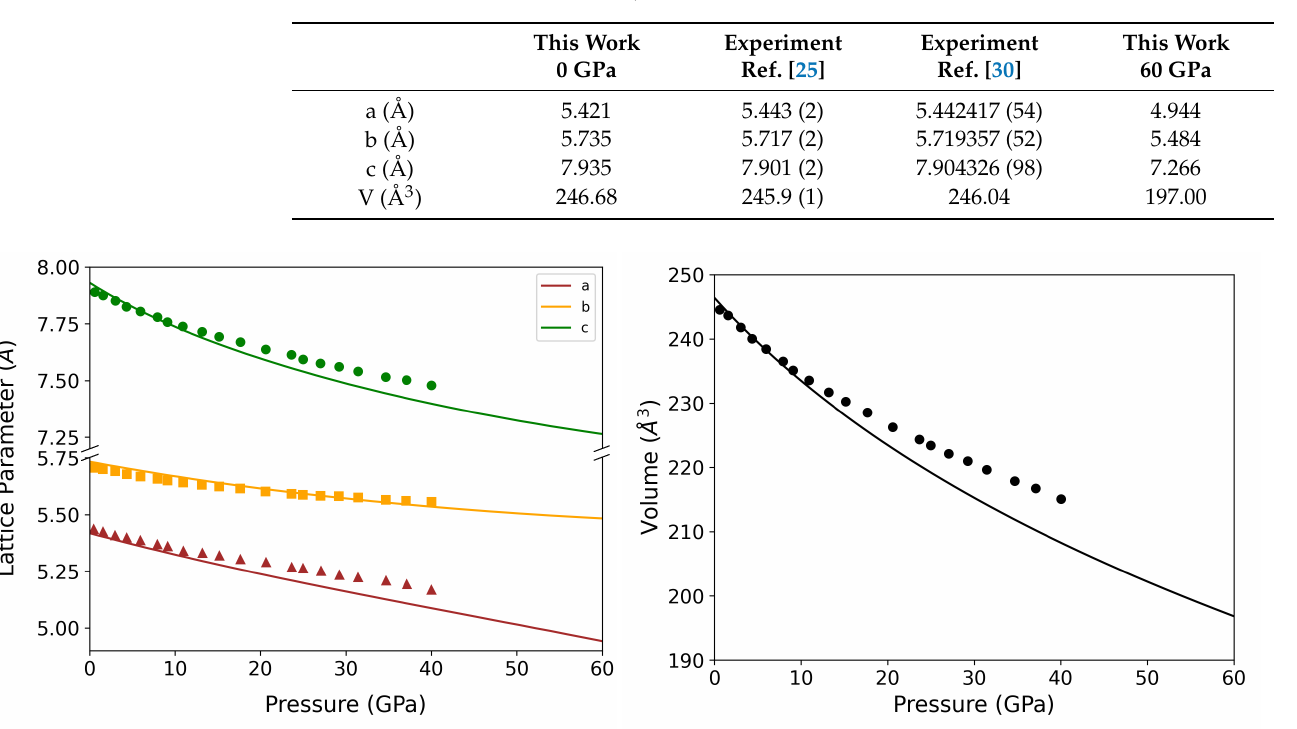
Figure 2. ( left ) Variation of the lattice parameters a , b , c of DyScO 3 perovskite with pressure. ( right ) Variation of the unit cell volume with pressure. In both panels, the curves represent our calculated values and the symbols represent the experimental values from Ref.